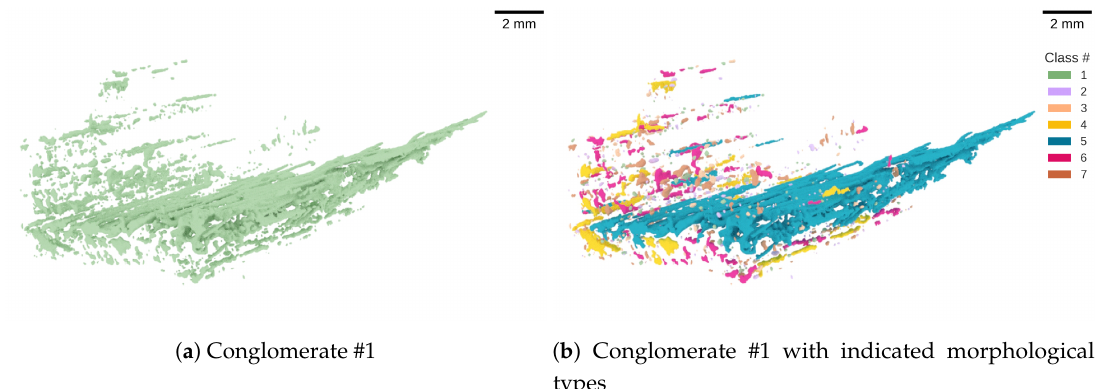
Figure 10. Conglomerates identified in specimen a3.